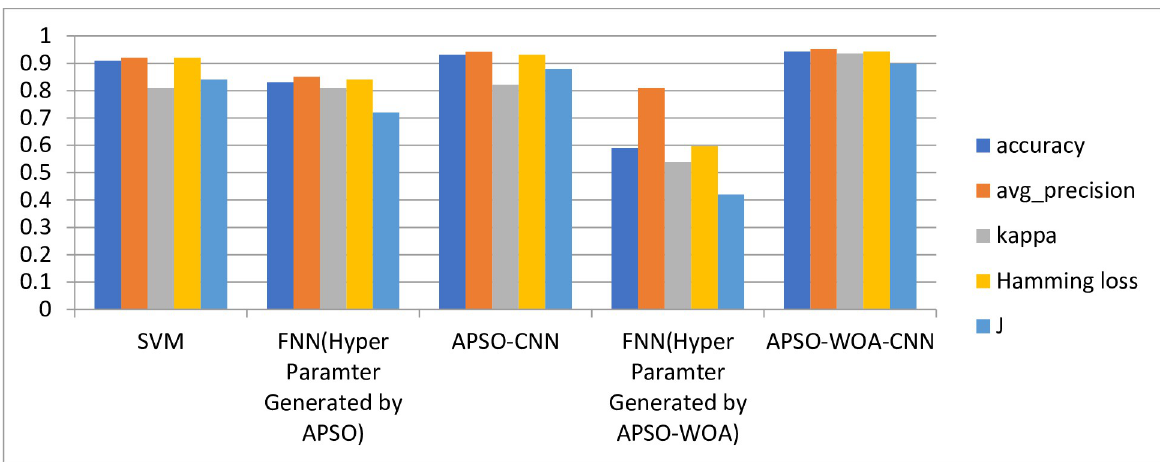
Fig 18. Evaluation index performance among algorithms.